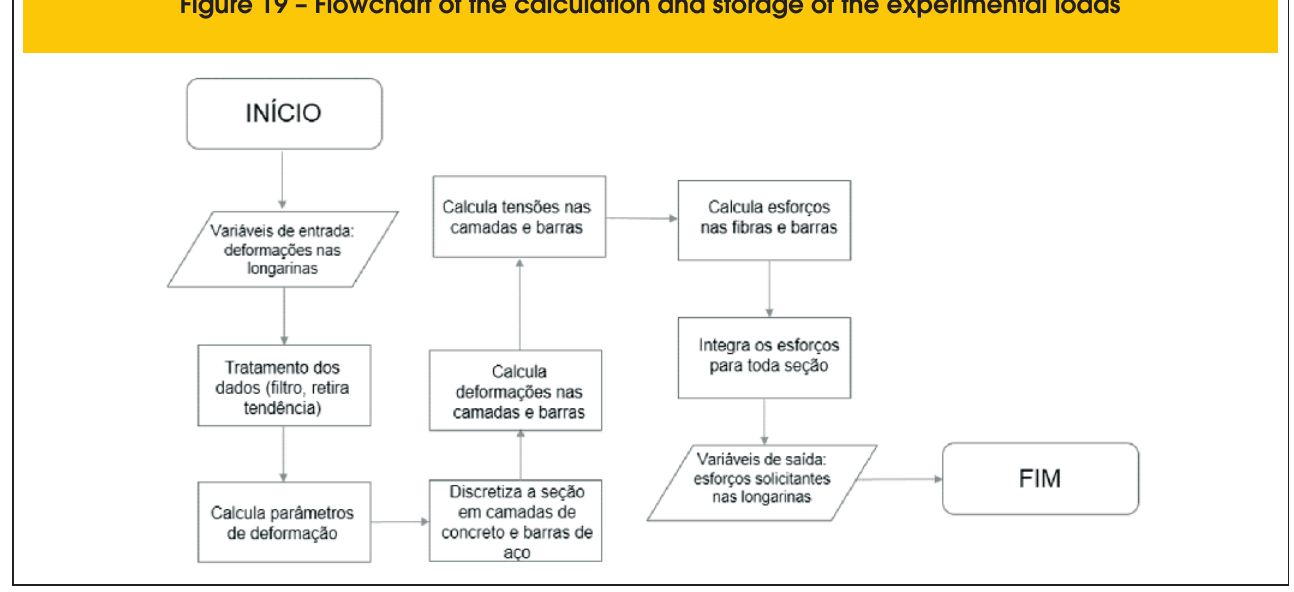
Figure 19 – Flowchart of the calculation and storage of the experimental loads